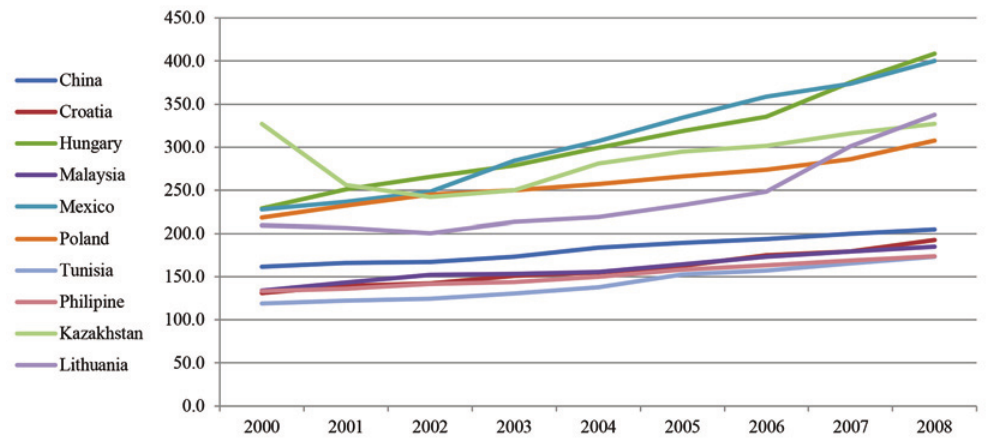
Figure 1. real house price increases in selected emerging economies: 2000–2008 Source: Global Market Information